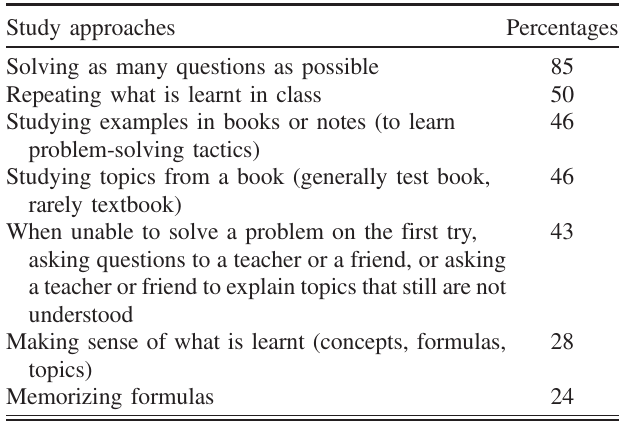
TABLE II. Coding categories for students ’ free responses to “ how do you study physics? ” .